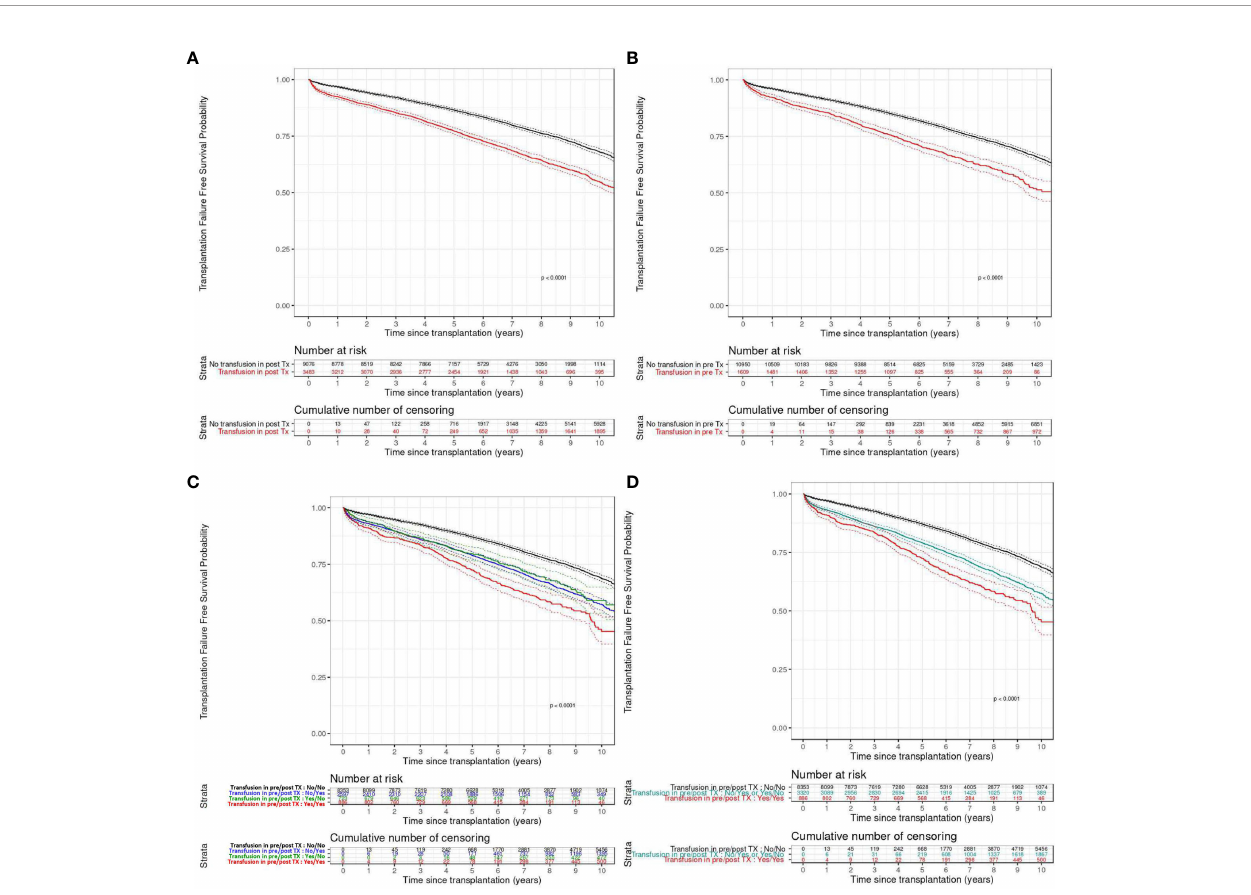
FIGURE 2 | Transplantation failure free survival according to the pre-transplant (A) , post-transplant (B) , or both pre and post-transplant (C, D) transfusion status. (A, B) Patients transfused (in red) or not (in black). (C) Patients transfused before transplantation (in green), after transplantation (in blue), both (in red) or not (in black). (D) Patients transfused before and after transplantation (in red), before or after transplantation (in blue) transplantation or not (in black). TX,